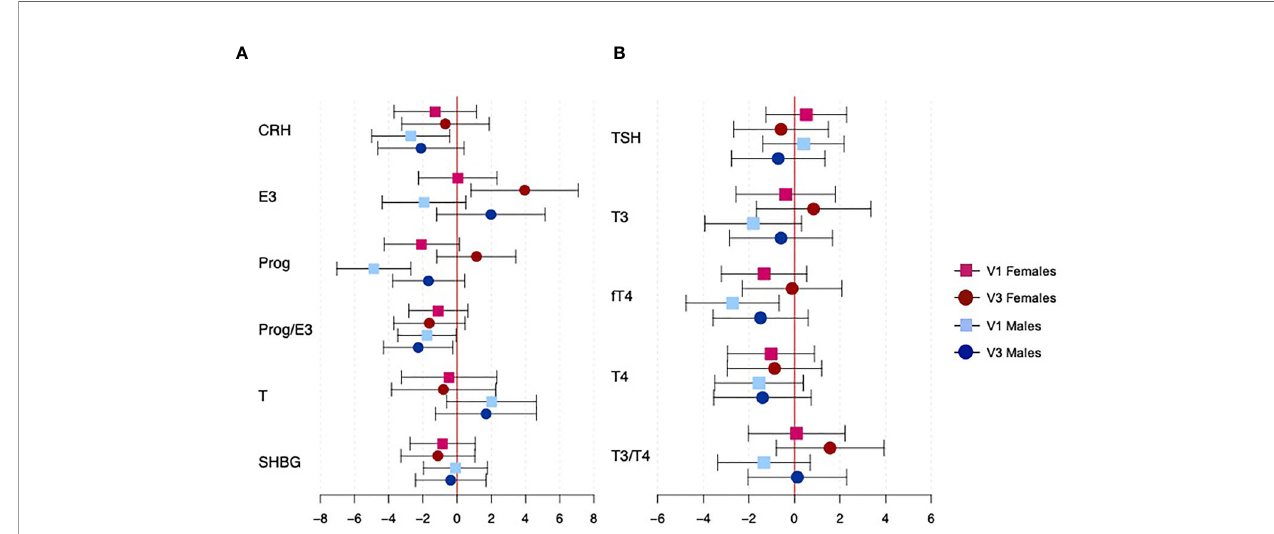
FIGURE 1 | Associations between hormone concentrations and gestational age at delivery, speci fi c to fetal sexes and study visit. Panel (A) shows CRH and reproductive hormones, and panel (B) shows thyroid hormones. Effect estimates represent the change in gestational age at birth (in days) with an interquartile range increase in hormone concentration. Red and blue estimates correspond to female and male fetuses, respectively. Squares denote effects from hormones at visit 1, while circles denote effects from hormones at visit 3.